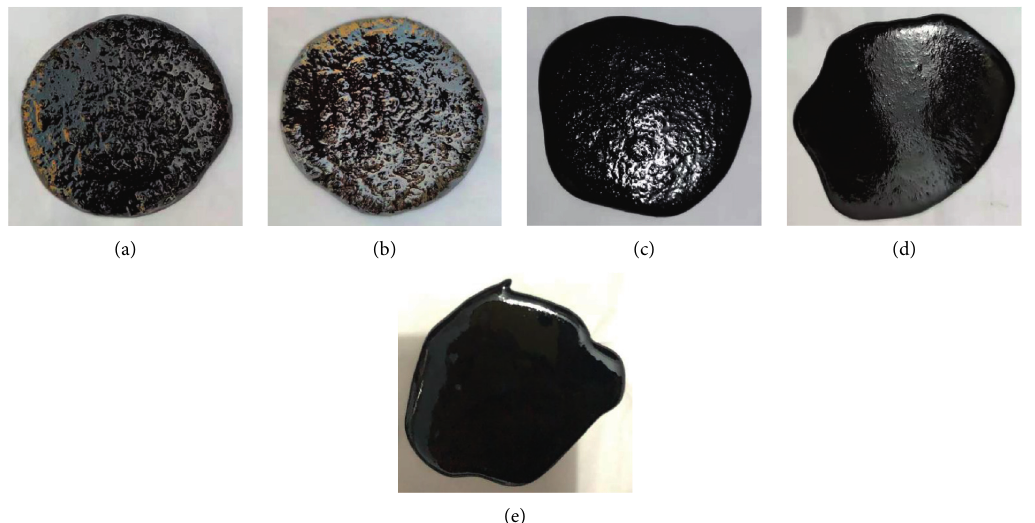
Figure 6: AR binders with different CR particle sizes. (a) AR with #20 CR, (b) AR with #30 CR, (c) AR with #40 CR, (d) AR with #60 CR, and (e) AR with #80 CR.